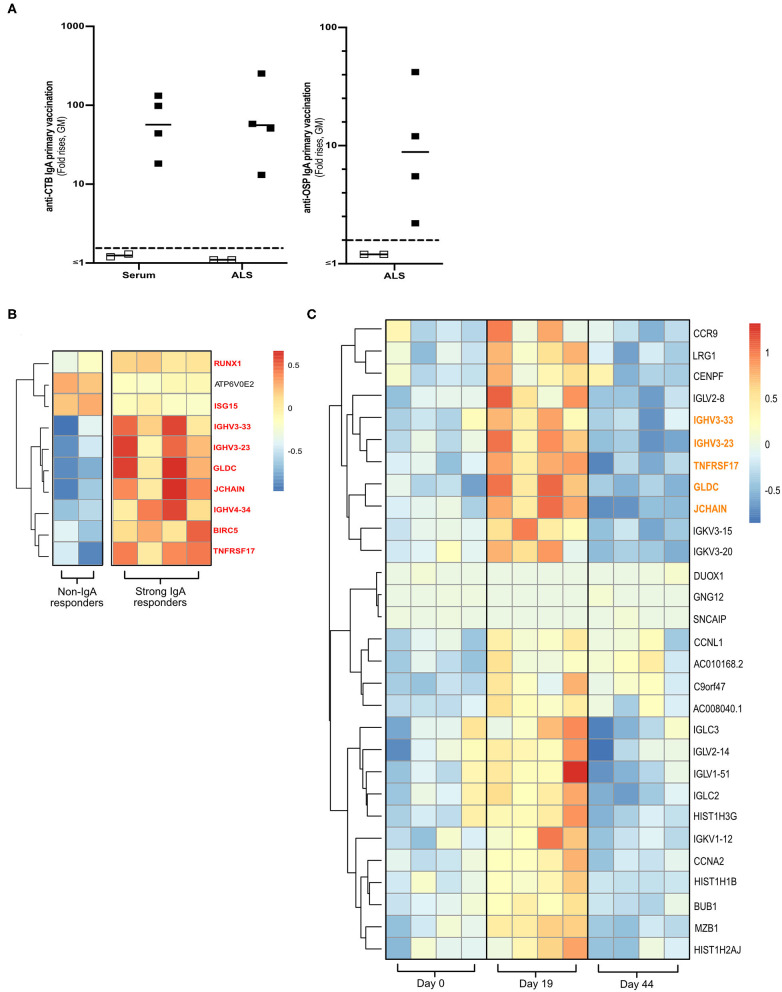
Transcriptomics analysis of PBMCs from Dukoral® vaccinated volunteers. (A) RNA-Seq analysis was performed on PBMCs from six Swedish volunteers who following two oral priming doses had either strong (n = 4, closed squares) or no (n = 2, open squares) IgA responses to the CTB and OSP antigens in the oral cholera vaccine. Volunteers with two-fold increases in IgA antibody responses are considered as vaccine responders (dashed line). Bars represent geometric means. (B) Heatmap of DEGs (padj < 0.05) of high vs. non-IgA vaccine responders that were enriched in Reactome pathways at day 19 post-vaccination. Unique DEGs to strong IgA vaccine responders are highlighted in red. (C) Heatmap of unique PBMC DEGs (padj < 0.05) that were enriched in Reactome pathway analysis at day 19 post-vaccination. Unique DEGs that were also identified in the strong vs. non-IgA vaccine analysis at day 19 post-vaccination are highlighted in orange. Color scales on Heatmaps; Red = up, White = no change, Blue = down regulated transcripts.